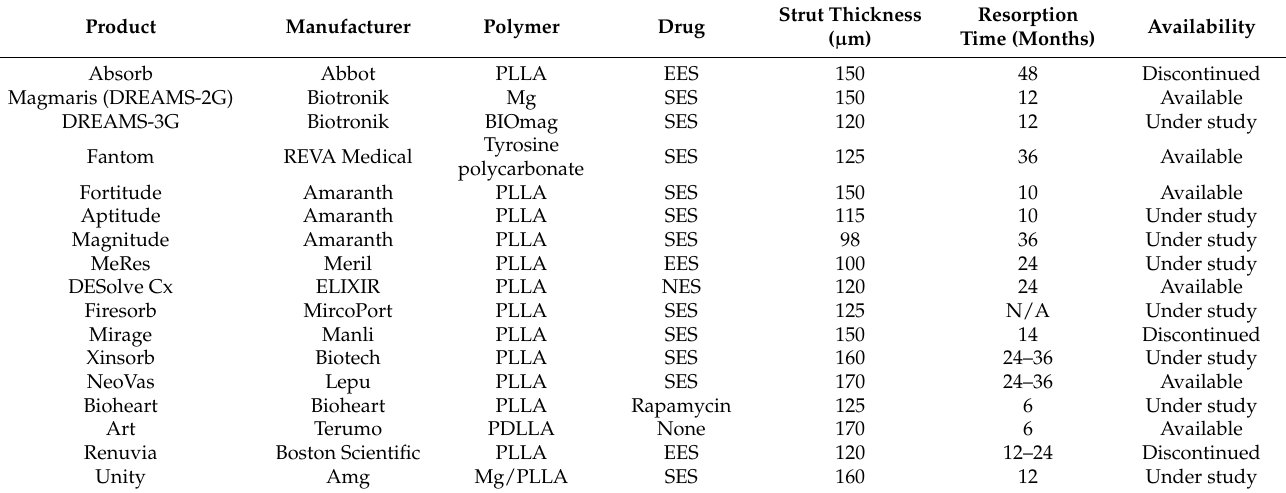
Table 1. Summary and comparison between currently available